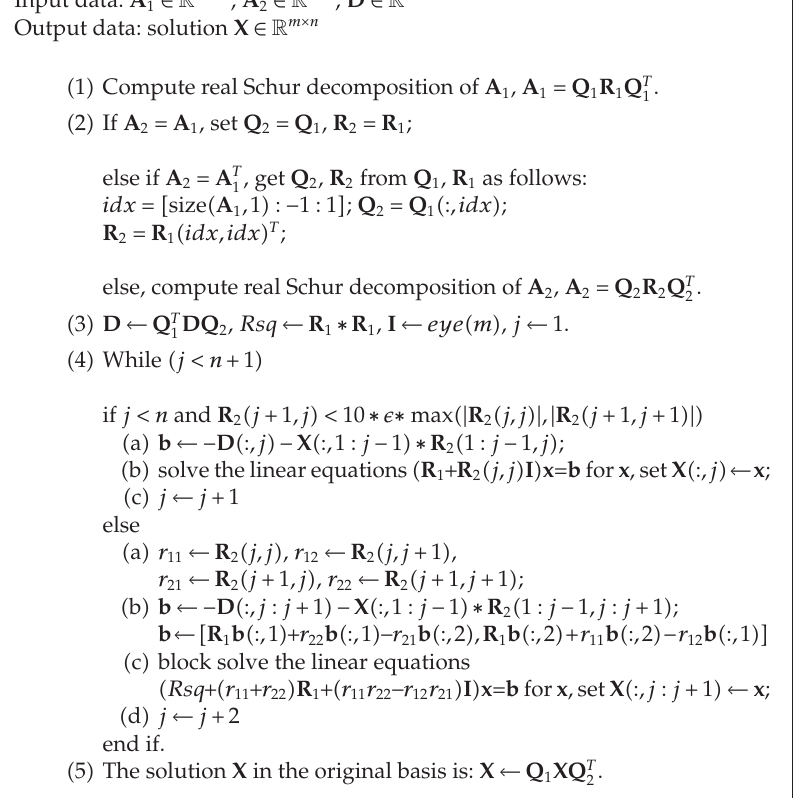
Algorithm 2.1 . The 2-solve scheme for Sylvester equation A